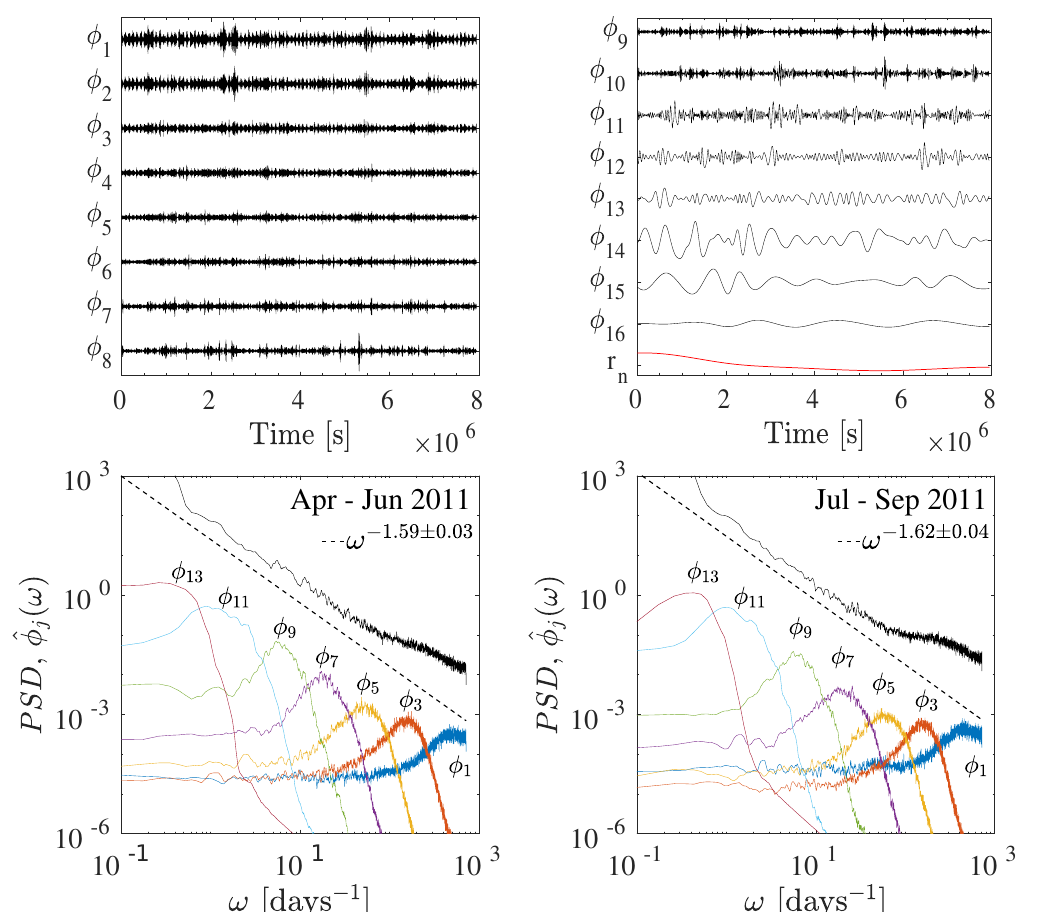
Figure 4. Upper panels : Intrinsic mode functions (IMFs) j ∈ [ 1,16 ] and the associated residual r n , obtained through Empirical Mode Decomposition (EMD) for sample April–June 2011. Lower left panel : Comparison of Fourier power spectral density ( black line ) for sample April–June 2011 with the Fourier power spectrum of different IMFs φ j ( ω ) , as a function of frequency ω (the curves have been shifted for clarity). The band-like structure of each IMF shows the dyadic nature of the decomposition. The dashed black line indicates the relation ω − 1.59 ± 0.03 . Lower right panel : same as previous case but for samples relative to the period July–September 2011. The dashed black line indicates the relation ω − 1.59 ± 0.03 . In order to enhance the readability of the two figures, only odd IMFs have been reported in the lower